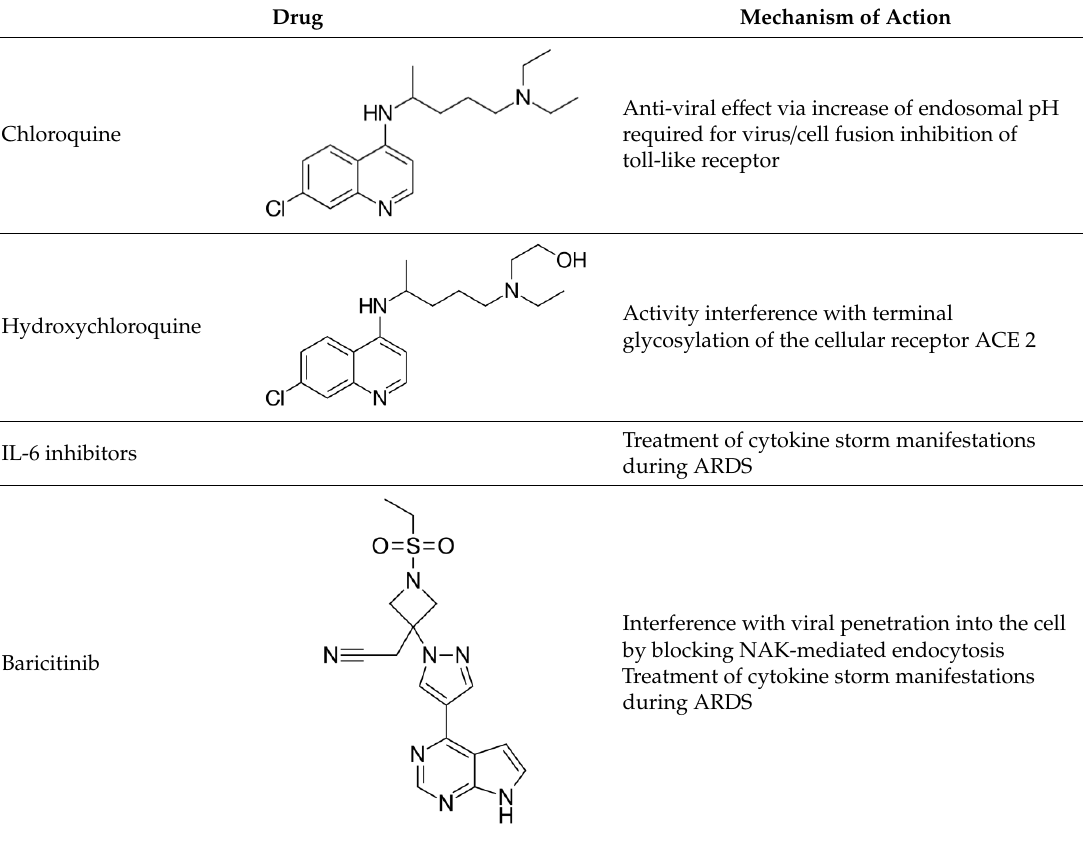
Table 1. Role of anti-rheumatic drugs in COVID-19 infection [71].